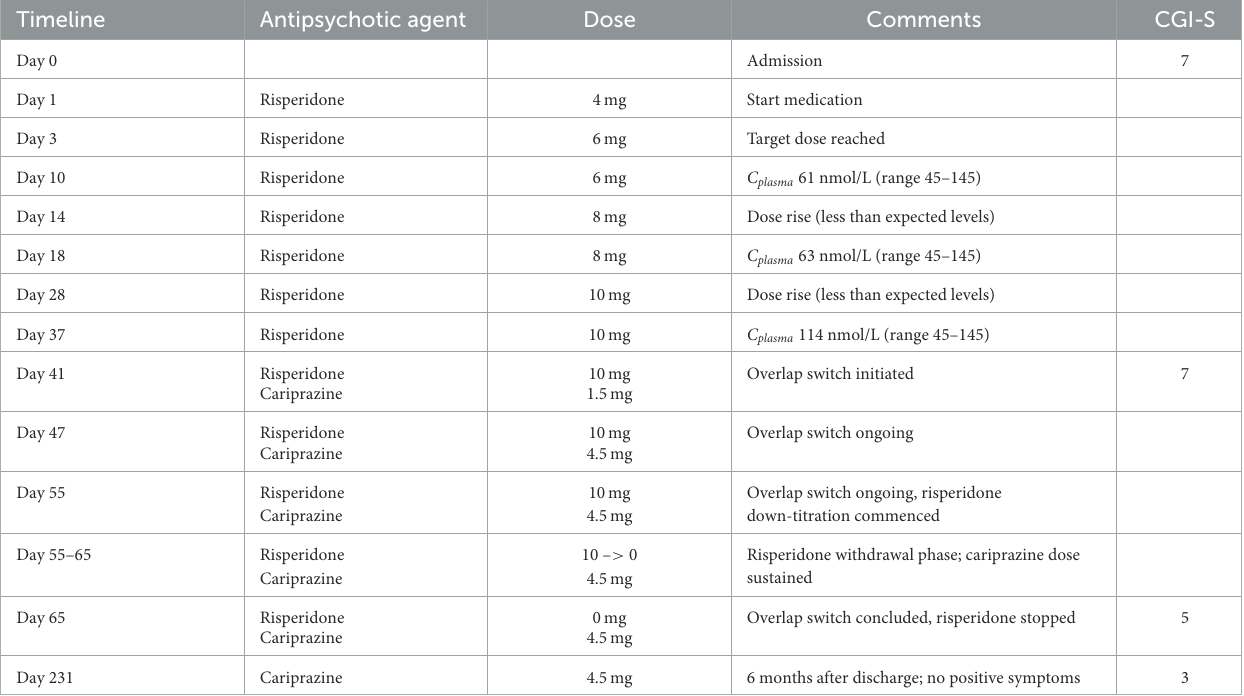
TABLE 1 Medication protocol and CGI scores prior to and upon switching from risperidone to cariprazine. Timeline Antipsychotic